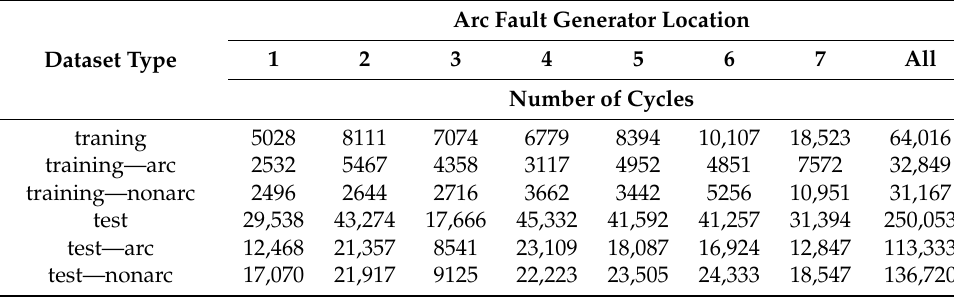
Table 2. Summary of the number cycles in training and test